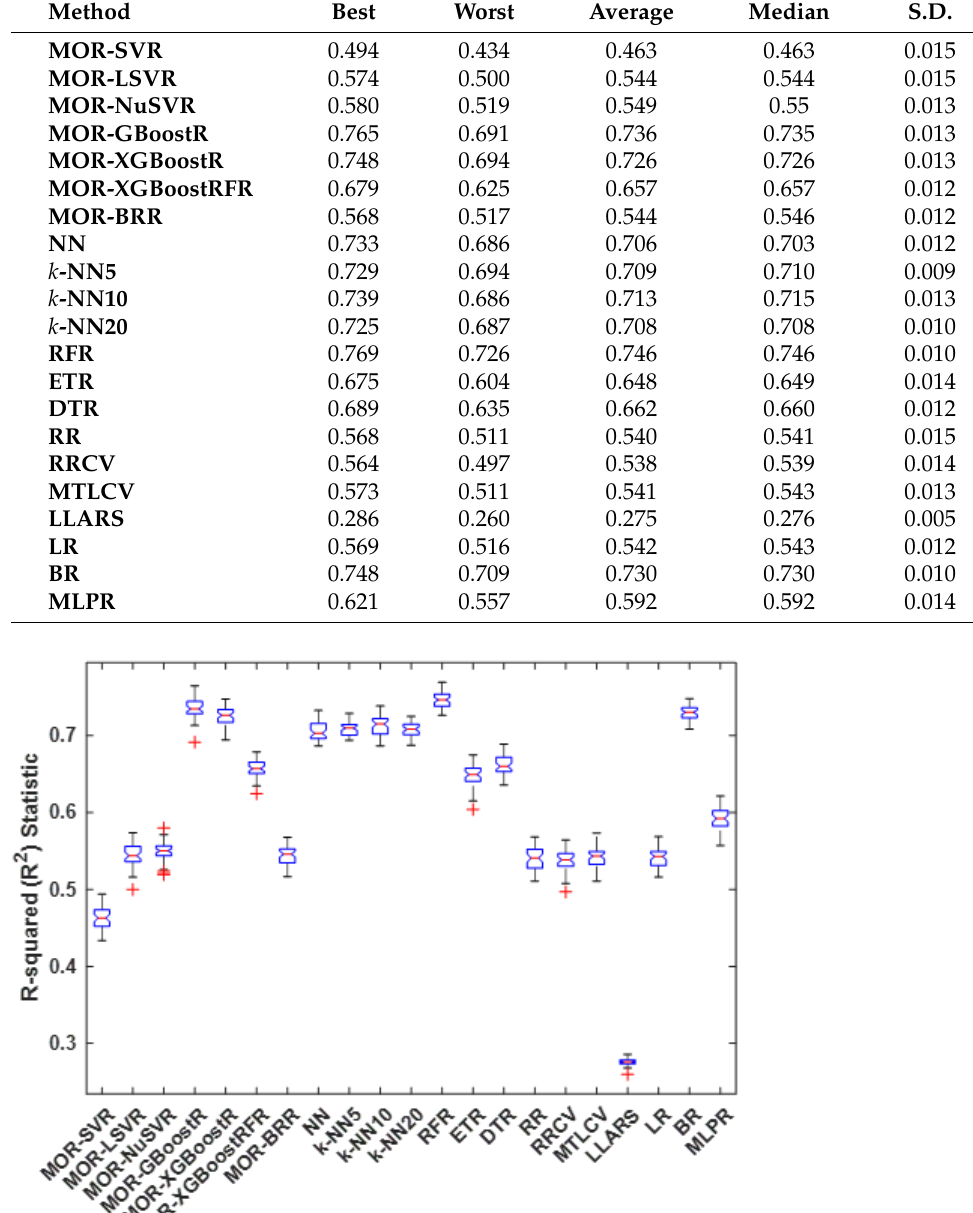
Table 9. R-squared value ( R 2 ) for all methods over 50 statistical runs (second stage).